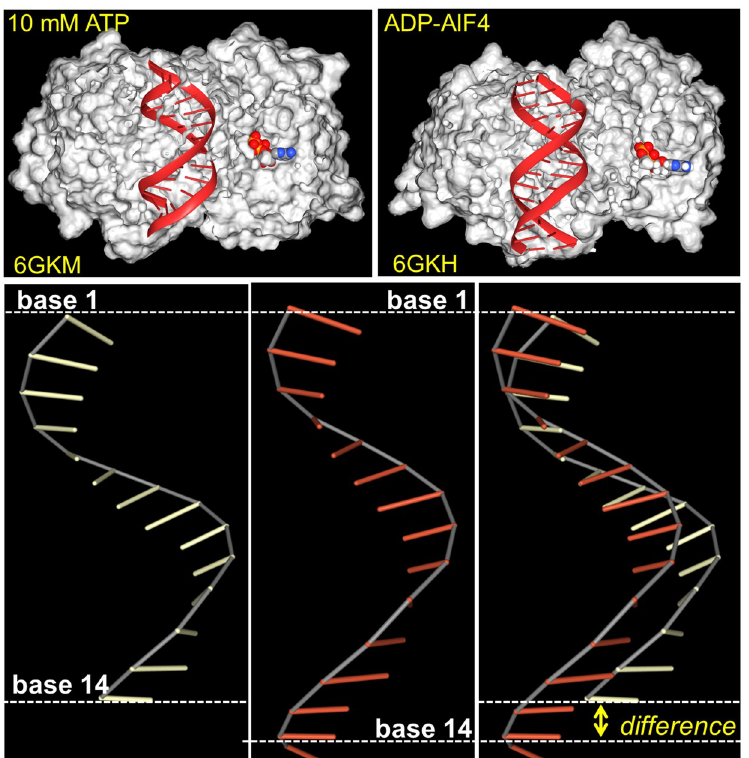
Fig 2. The dsRNA helix is shortened in ATP-bound MDA5 filaments. The upper figures show MDA5 bound to dsRNA and to either ATP (upper and lower left) or to the ATP transition state analog adenosine diphosphate- tetrafluoroaluminate (ADP-AIF 4 ) (upper right and lower middle). A cross section of the surface representation of the protein allows visualization of the bound dsRNA and the nucleotide ligand (to the right of the dsRNA in the upper images). The lower figures show only 1 strand of the RNA double-helix (dsRNA) from the cryo-EM structures described in PDB records 6GKM and 6GKH to emphasize the difference in the relative position of the RNA base 14 in the 2 complexes due to differences in how the filament twists [49]. The compact MDA5 complex in the ATP bound form has 5 MDA5 subunits per step, corresponding to a twist of approximately 72˚ for each. The ADP-AIF 4 complex has 4 subunits per step, corresponding to a twist approximately 90˚ for each [49]. The extra twist of the ATP filament is associated with an increased inclination of the bases [83]. It creates torsion of the adjacent dsRNA that can be relieved by unwinding the dsRNA into single-stranded RNAs [49]. Under the model described here, the strain is released by flipping the right-handed A-form dsRNA (24.6 Å ) to the longer left-handed Z-RNA conformation to (45.6 Å ), triggering ATP hydrolysis as MDA5 releases. ATP, adenosine triphosphate; dsRNA, double-stranded RNA; MDA5, melanoma differentiation–associated gene 5; PDB, Protein Data Bank